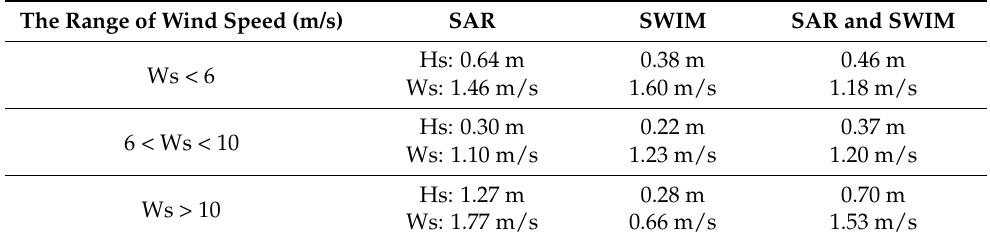
Table 1. The RMSE between the parameters of the three methods and ERA5 were obtained under different wind speed ranges. The Range of Wind Speed (m/s) SAR SWIM SAR and SWIM Hs: 0.64 m Ws < 6